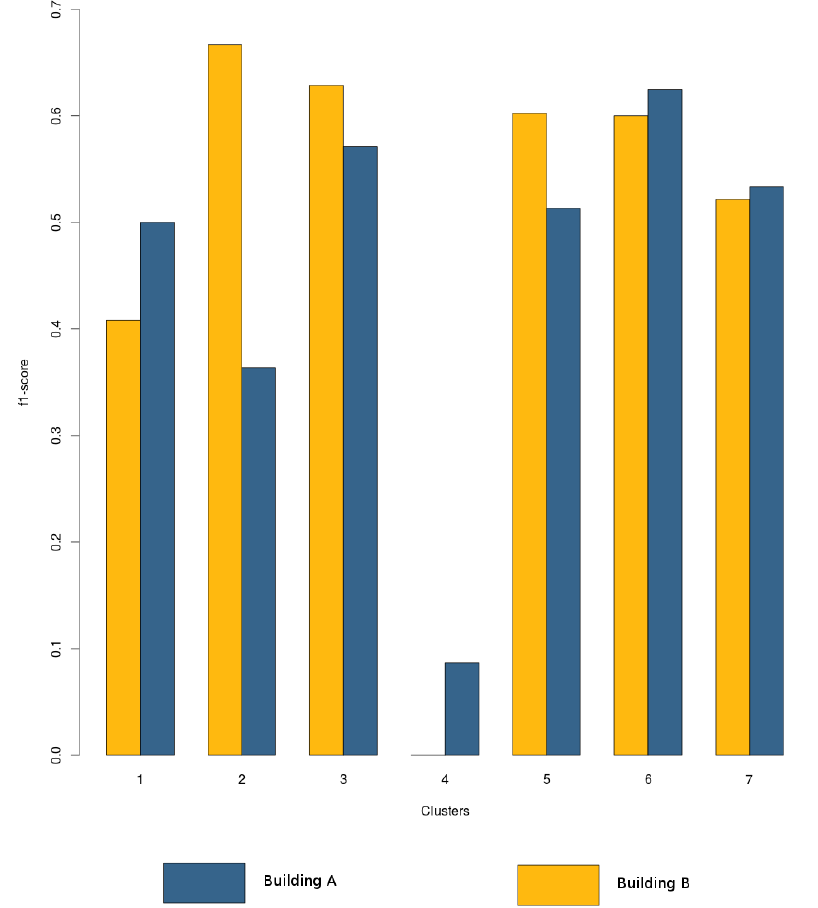
Figure 11. Comparison between classification based on features selected from Building A and